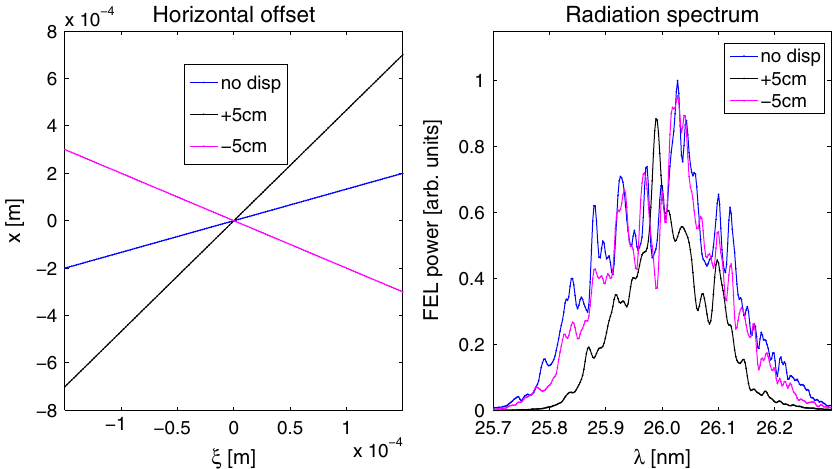
FIG. 13. (Color) Dispersion effects on the wavelength spectrum for an initial linear x -energy correlation.